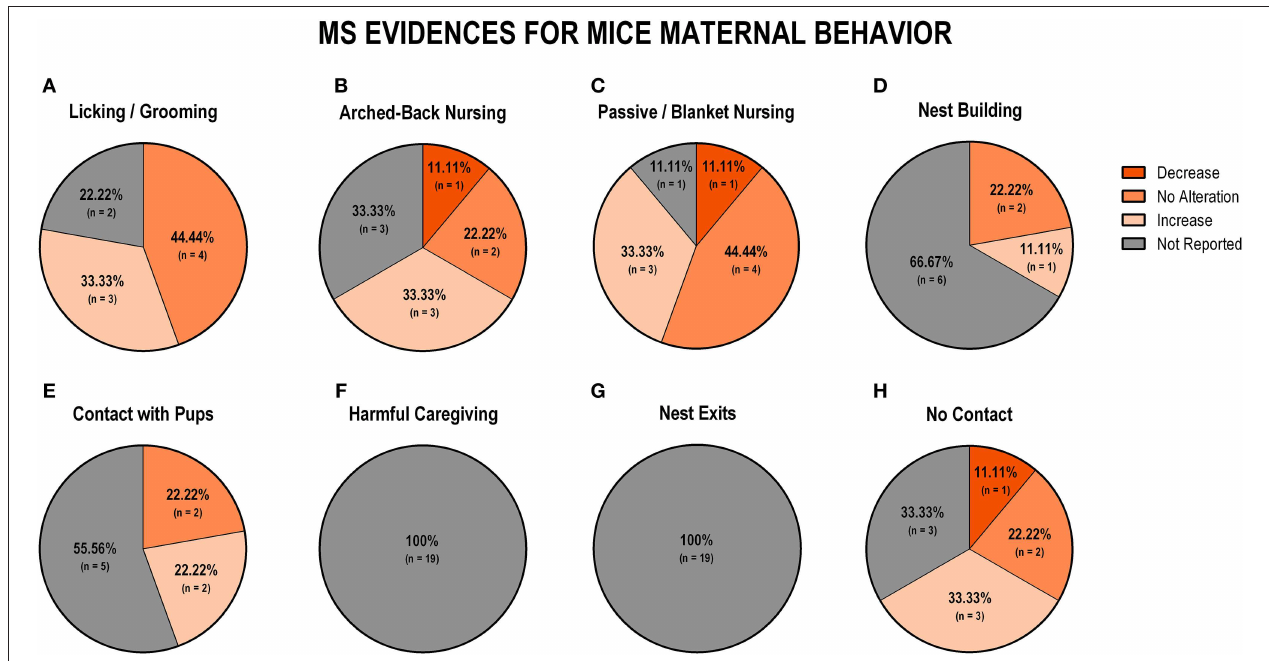
FIGURE 6 | Percentage of behavior findings from MS mice studies. Licking and grooming behavior (A) . Arched-back nursing behavior (B) . Passive and blanket nursing behavior (C) . Nest building behavior (D) . Contact with pups behavior (E) ; Harmful caregiving behavior (F) . Nest exits behavior (G) . No contact behavior (H) .